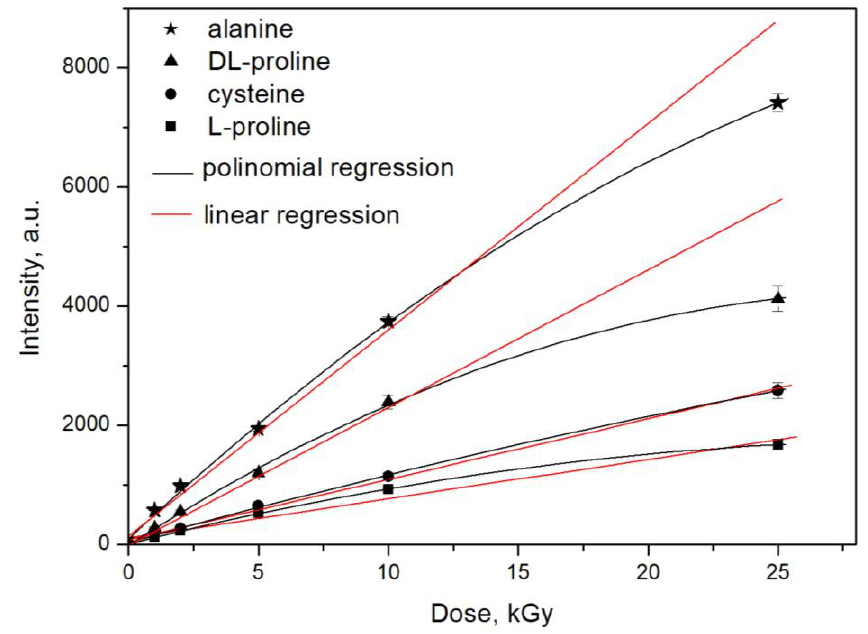
Figure 8. Dependence of the EPR signal intensity on the applied dose of gamma radiation.